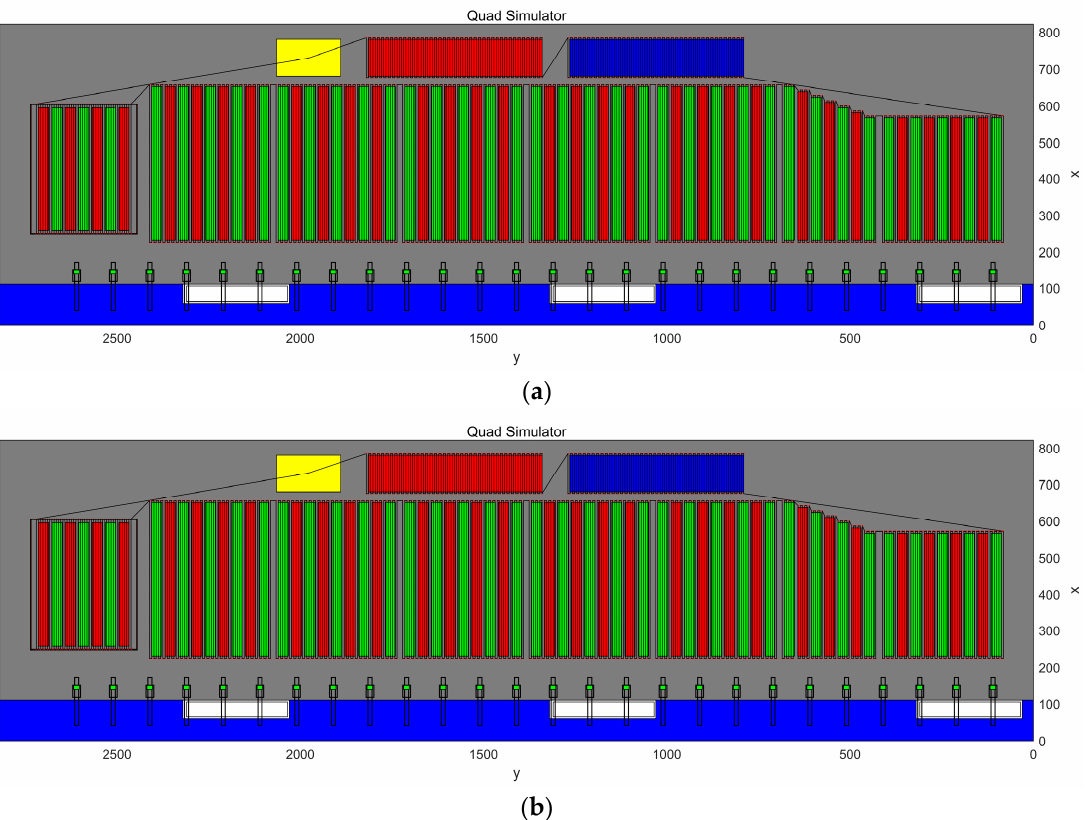
Figure 9. Detection paths generated by the algorithms in Scenario 1. ( a ) Path generated by the bias_RRT* algorithm. ( b ) Path generated by the improved bias_RRT* algorithm.